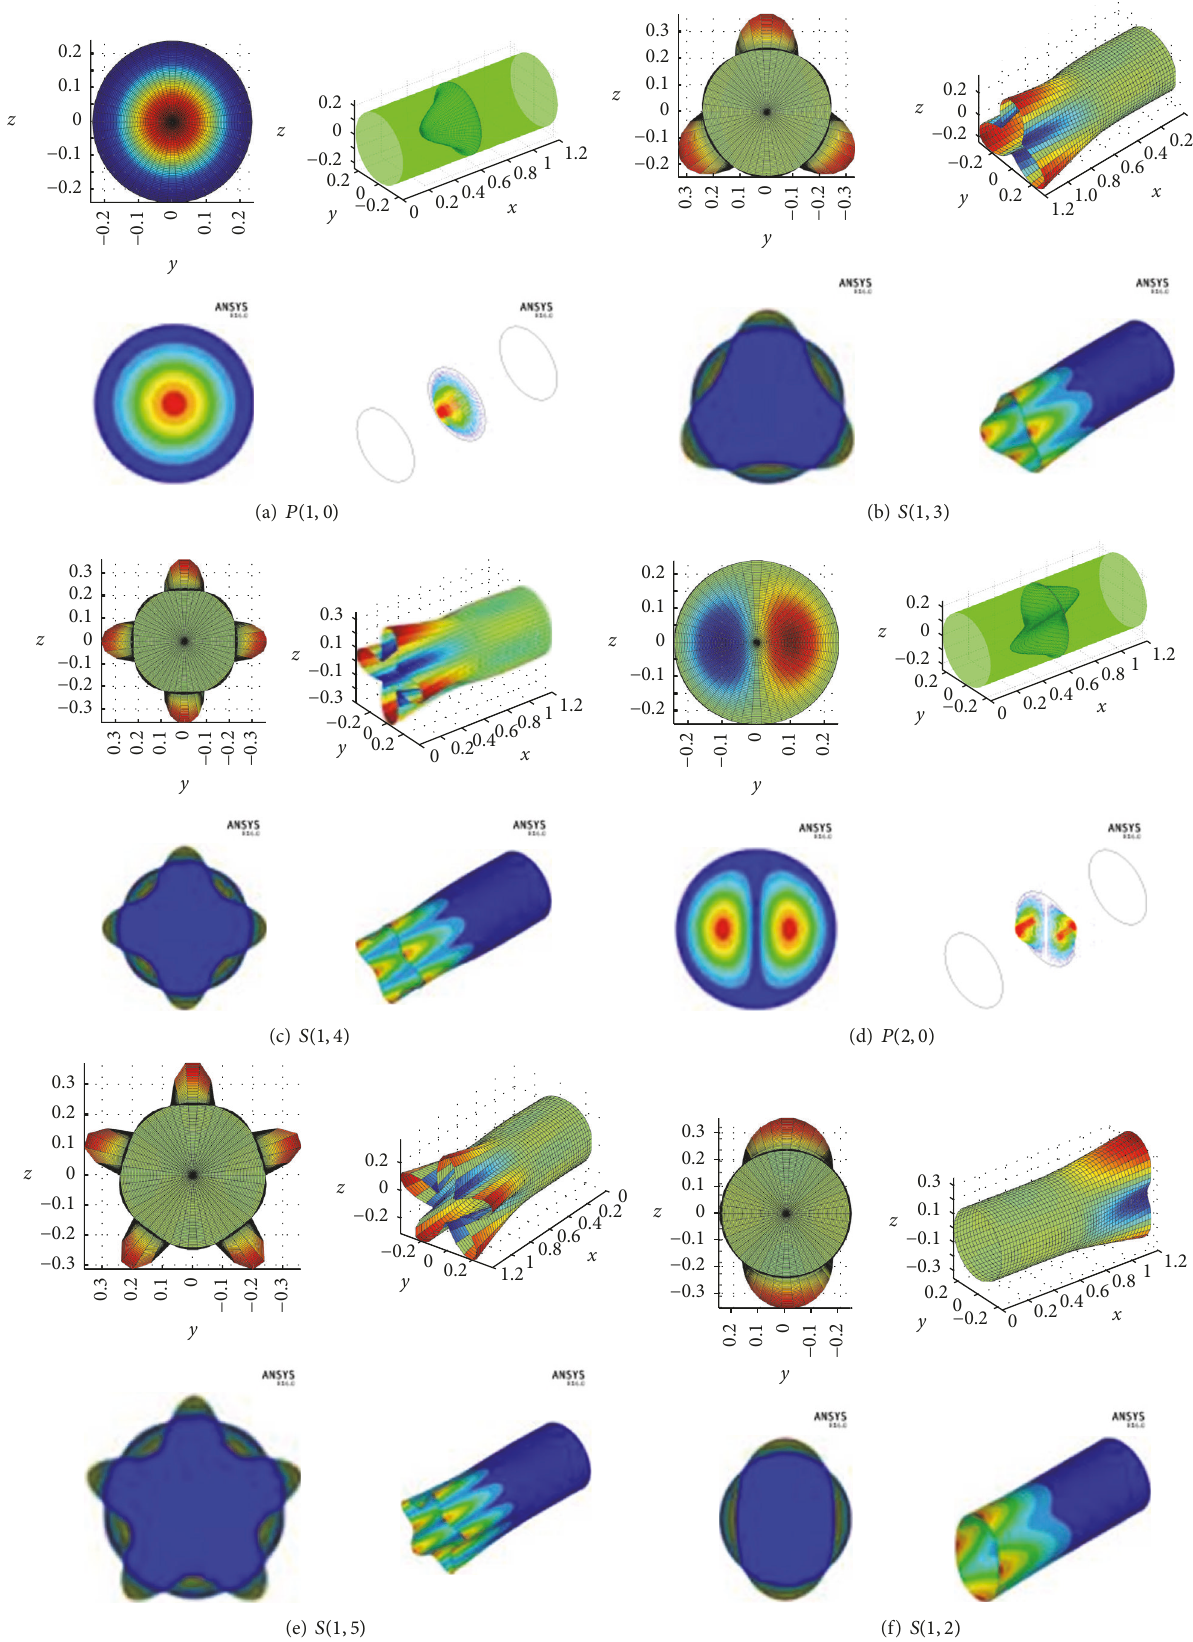
Figure 5: The modes of coupled structures with